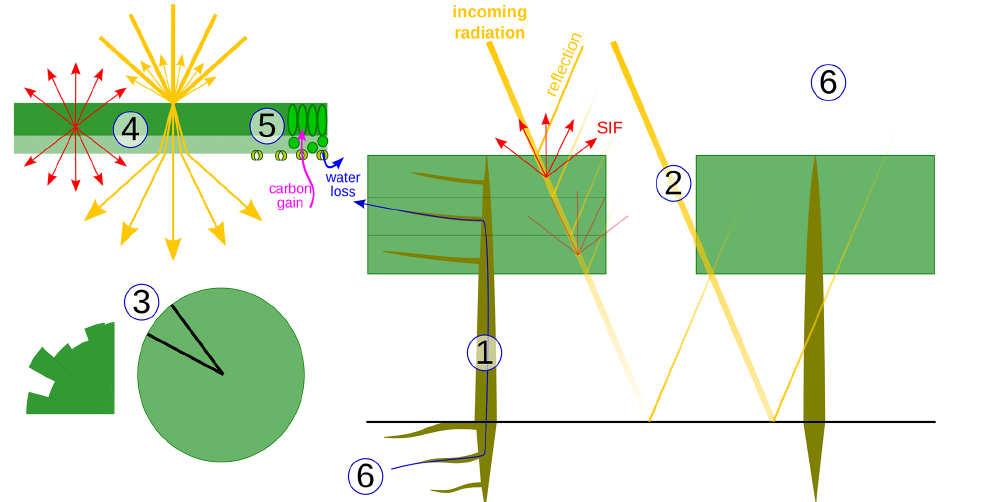
Figure 1. Diagram of the CliMA Land model. CliMA Land is built on a highly modularized plant hydraulics module (labeled using 1). The plant hydraulic system has multiple roots, each tapping water in the corresponding soil layer; an optional trunk that elevates the plant canopy; and multiple branches, each connected to the corresponding canopy layer. The radiative transfer module within the canopy (labeled using 2) is responsible for simulating canopy-level light scattering by accounting for leaf angular distributions (labeled using 3) and leaf- level hyperspectral reflectance, transmittance, and fluorescence spectra (labeled using 4). The stomatal control module determines stomatal opening at the leaf level by assessing the photosynthetic and hydraulic status of the plant (labeled using 5) as well as environmental conditions (labeled using